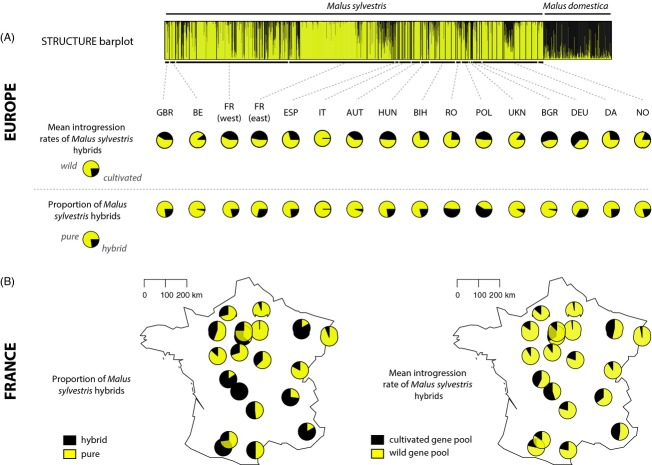
Geographical quantification of introgression rates and numbers of hybrids among European wild apple sites in Europe and, more specifically, in France. (A) STRUCTURE barplot for K = 6, for the European wild apple gene pool (yellow) and the cultivated apple gene pool (black) at the European scale (N = 2228, 66 sites); below, associated country-averaged introgression rates (PDOM→SYL) and number of hybrids. GB: Great Britain, BE: Belgium, FR (west): Western France, FR (east): Eastern France, ESP: Spain, IT: Italy, AUT: Austria, HUN: Hungary, BIH: Bosnia Herzegovina, RO: Romania, POL: Poland, BGR: Bulgaria, UKN: Ukraine, DEU: Germany, DA: Denmark, NO: Norway. (B) Site-averaged introgression rates (PDOM→SYL) and number of hybrids in France (N = 1092, 20 sites).